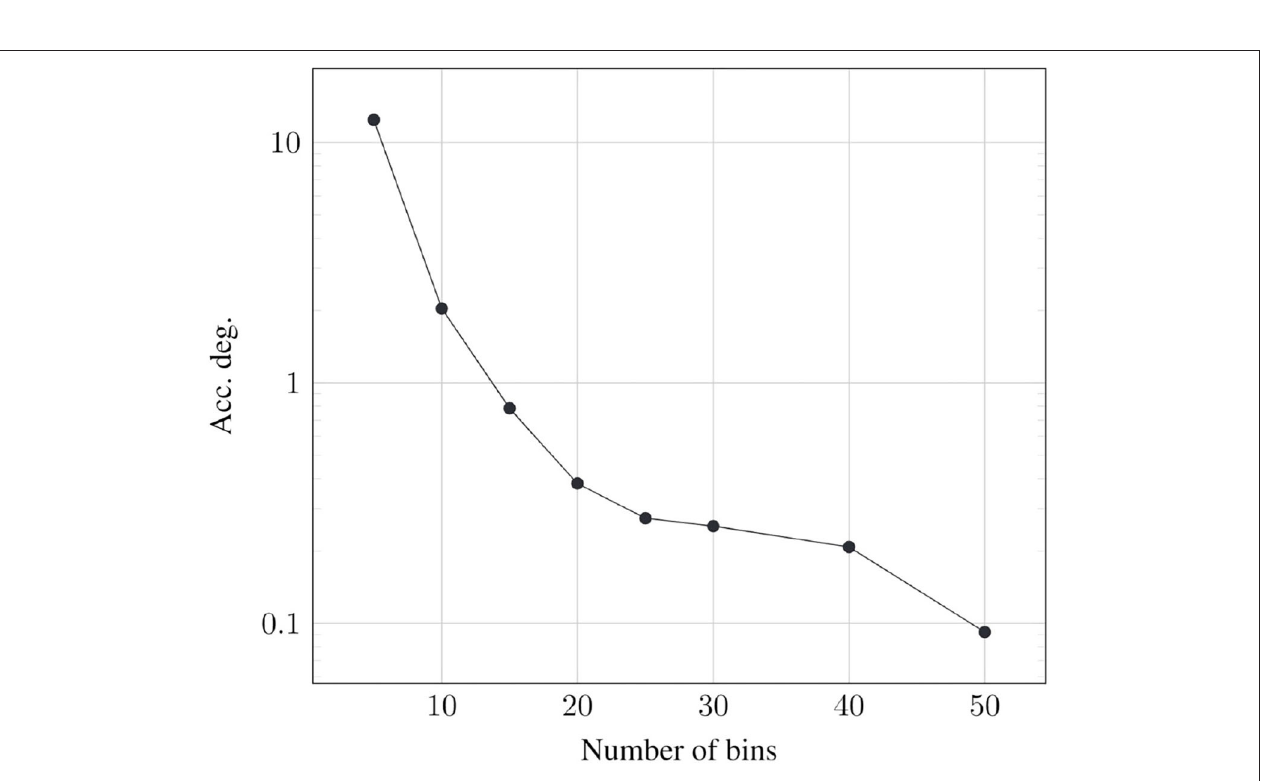
FIGURE 14 | Optimal resolution of cumulative histogram for